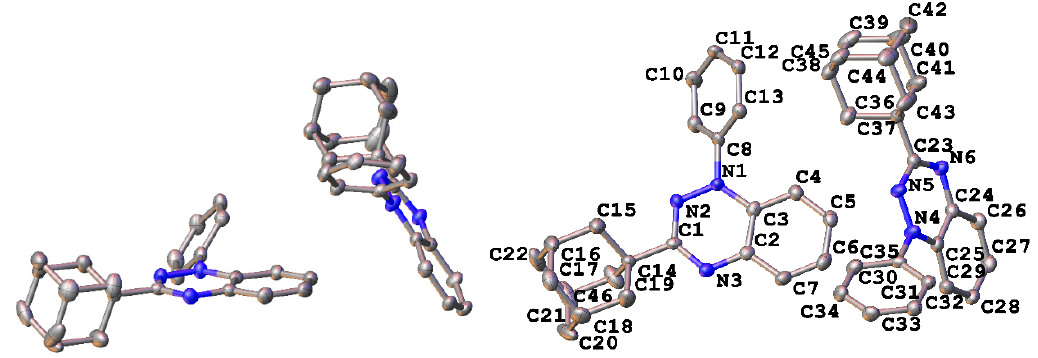
Figure 3. Asymmetric unit ( left ) and crystallographic atom numbering for 3-adamantyl-1,2,4- benzotriazinyl 4 ( right ). Hydrogen atoms omitted for clarity.